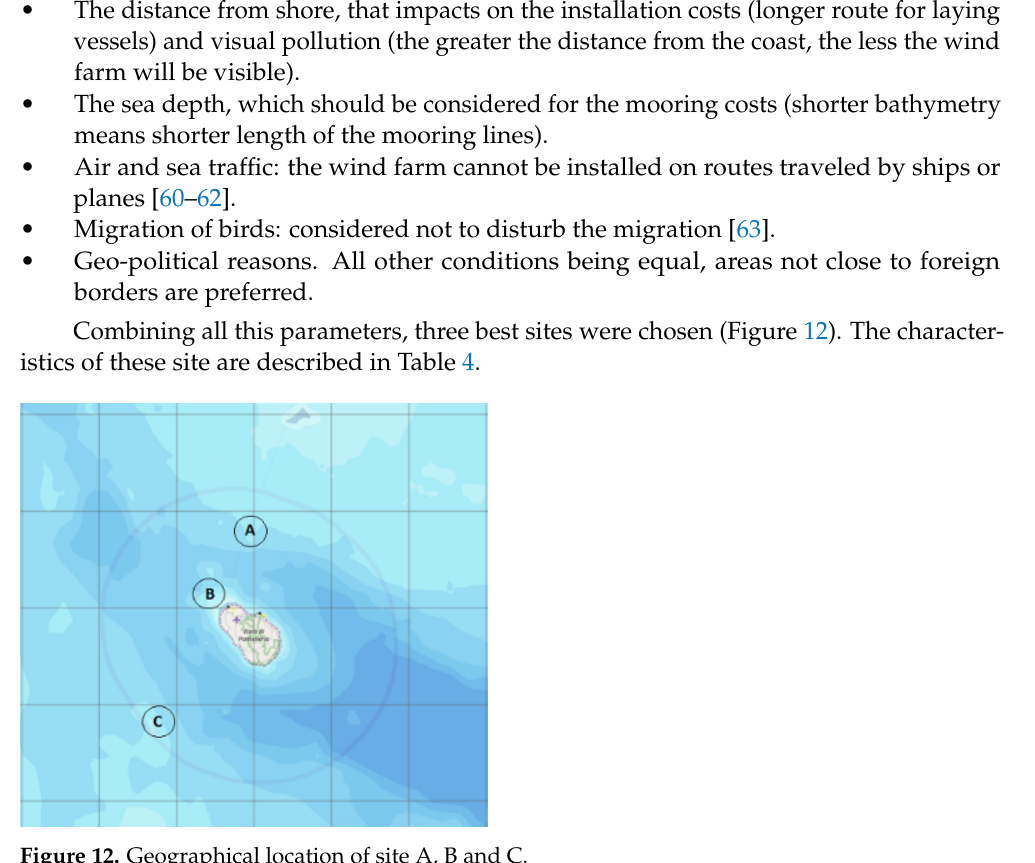
Figure 12. Geographical location of site A, B and C. Table 4. Charateristics of study